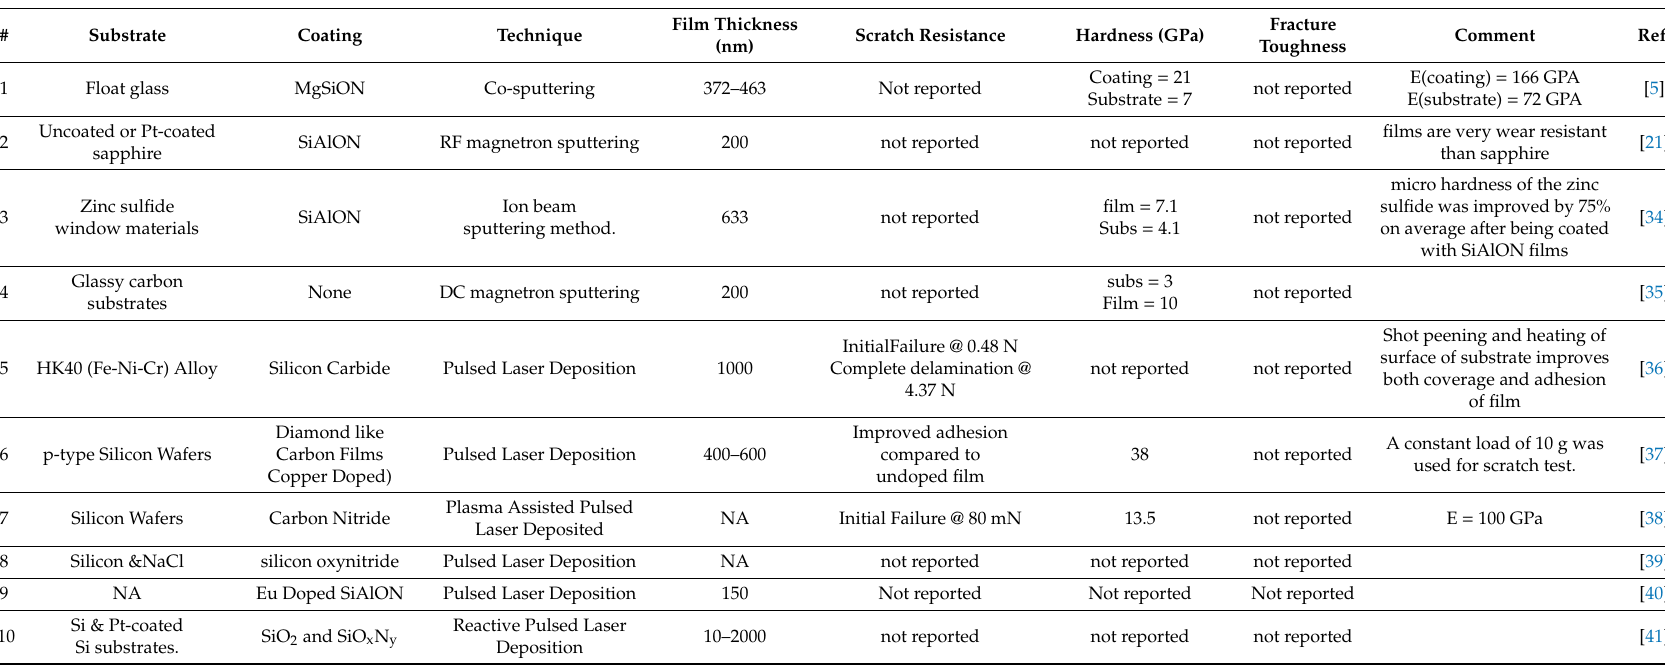
Table 4. The mechanical properties (scratch resistance, hardness, and Fracture Toughness) of thin film materials reported in the